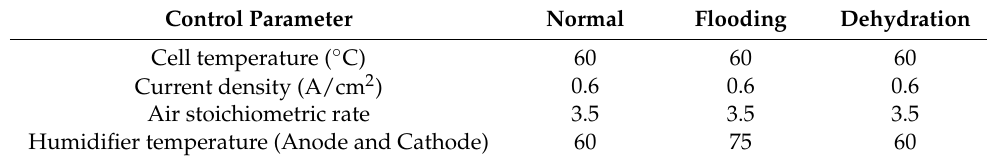
Table 2. Test control